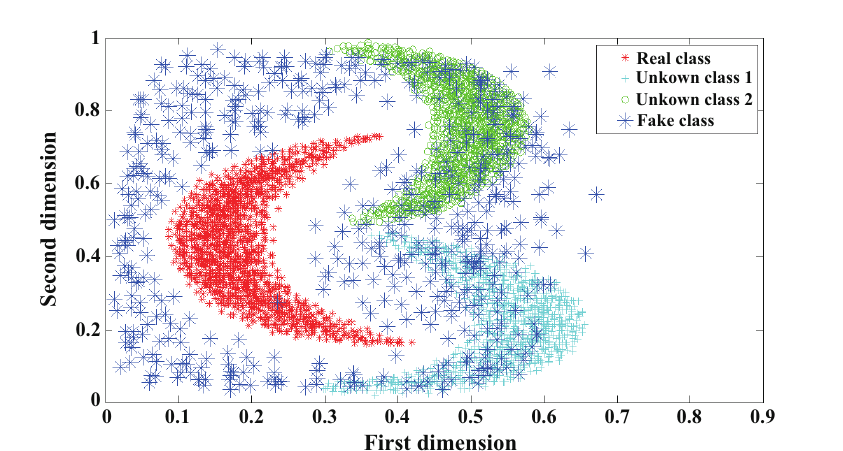
Figure 5. Feature distribution of the generated fake samples.